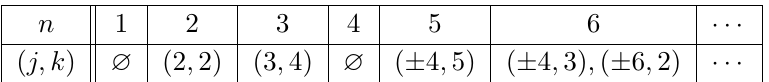
Table 1 . list of ( (cid:13) 0 ; k ) = ([ j e ] ; k ) satisfying the condition (2.35) when (cid:3) S = h +2 n i 2 n